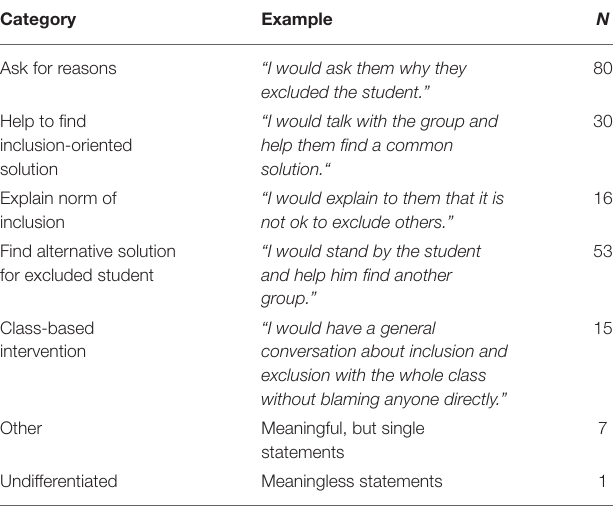
TABLE 2 | Coding system for specific actions and frequencies for each